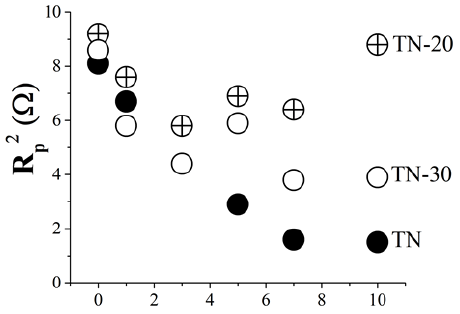
Figure 7. Evolution of resistance parameter R p2 from the second part of equivalent circuit for samples during their storage in saline (inorganic fraction of DMEM) for 10 days.